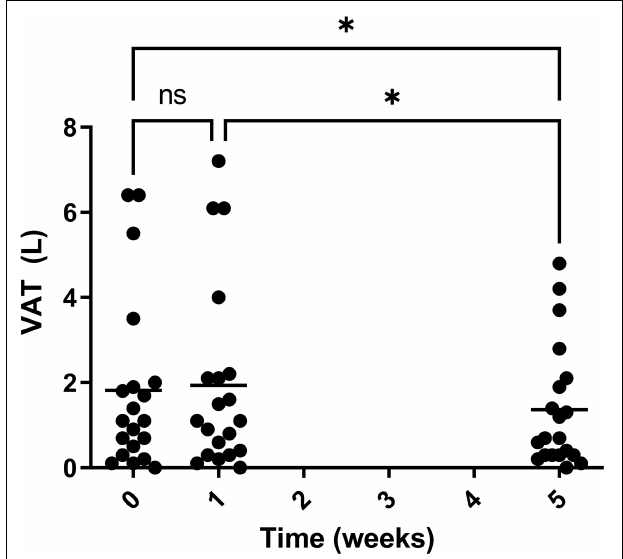
FIGURE 12 | Visceral adipose tissue (VAT) of participants throughout the trial. Week 1 represents a second measurement after a control week of normal diet. Week 5 represents a third measurement after 4 weeks of a 100% Huel diet. The mean VAT of all the participants who completed the trial, with asterisks denoting statistical differences.